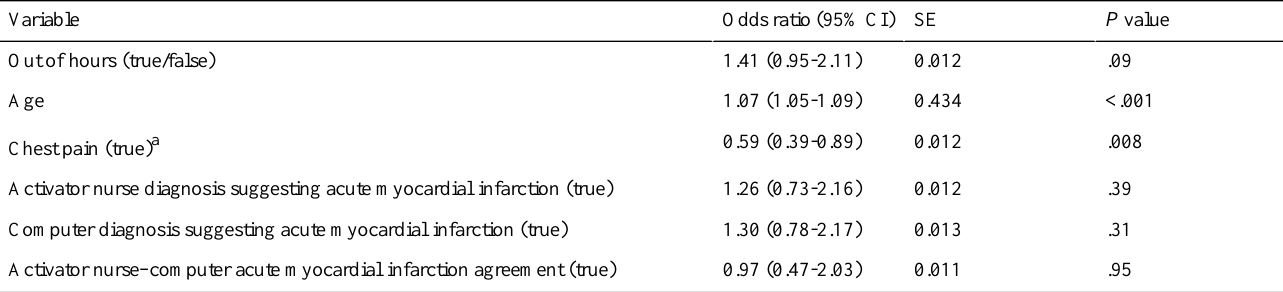
Table 1. Odds ratios of variables derived from multiple logistic regression where the response variable was mortality after 1 year.